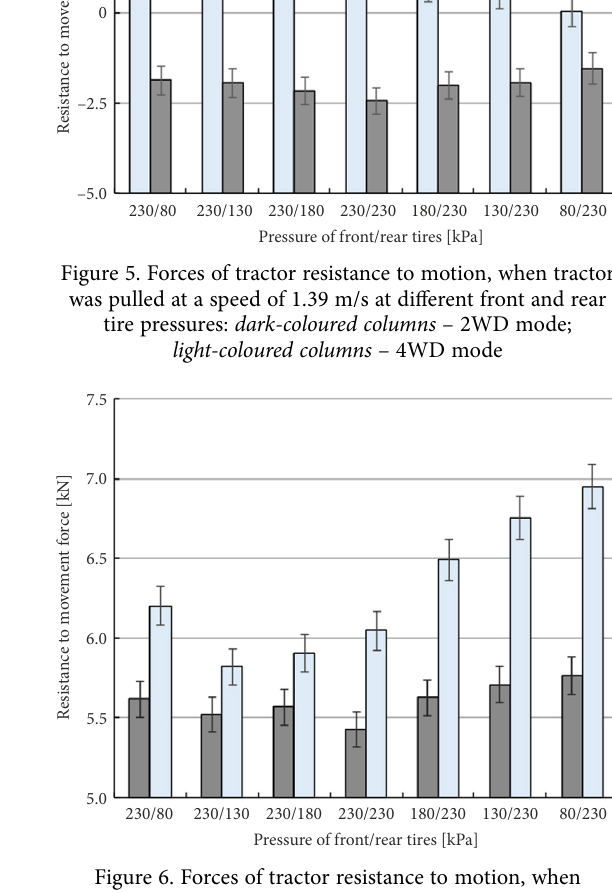
Figure 6. Forces of tractor resistance to motion, when the tractor was engine braked, at different front and rear tire pressures: dark-coloured columns – 2WD mode; light-coloured columns – 4WD